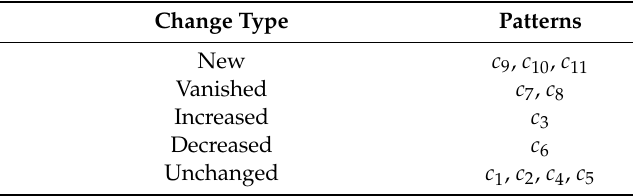
Table 3. Change detection results for User 2.